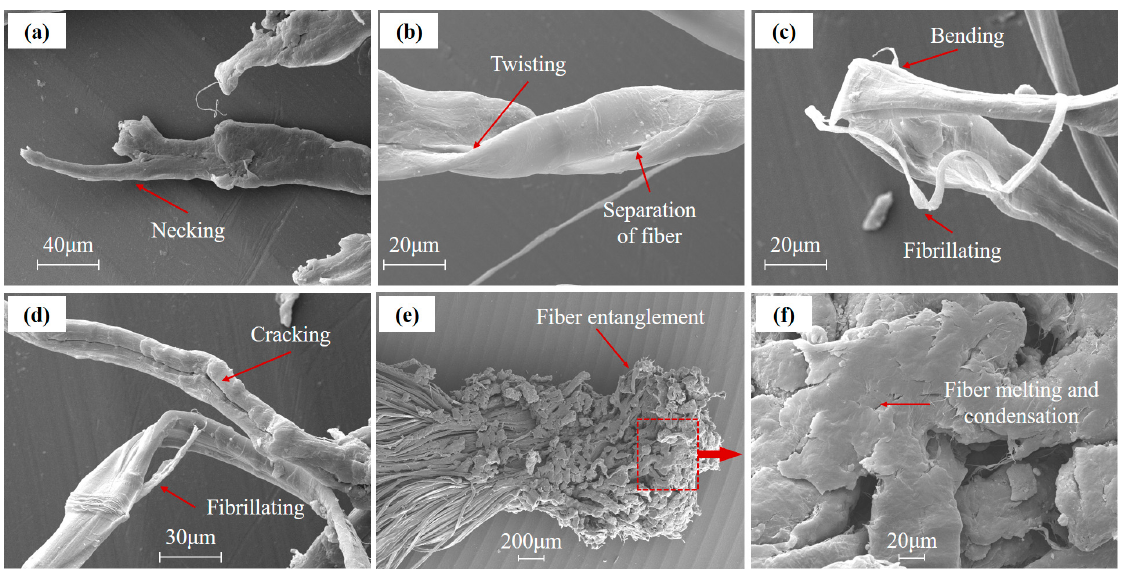
Figure 10. The SEM images of damaged UHMWPE fiber. ( a ) Necking of fiber. ( b ) Twisting and separation of fiber. ( c ) Bending and fibrillating of fiber. ( d ) Cracking of fiber. ( e ) Entanglement of fiber. ( f ) melting and condensation of fiber.